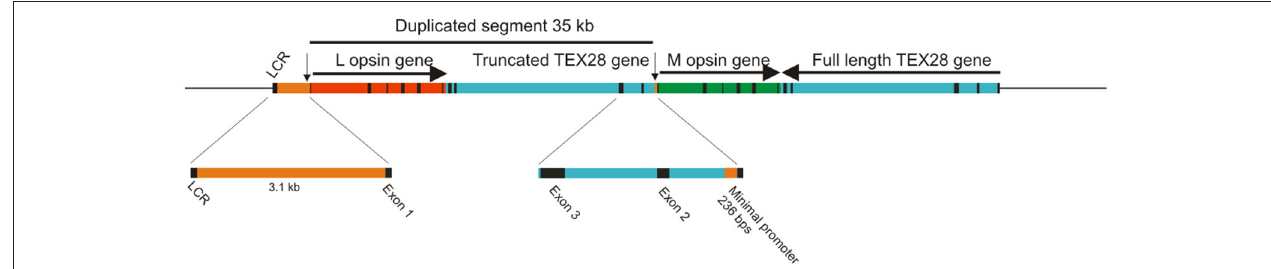
FIGURE 1 | Origin of opsin gene duplication on the X chromosome of Old World primates. The exons for the L and M opsin genes and for the TEX28 gene are shown as black bars. Arrows indicate the direction of transcription. The positions of the upstream LCR and the minimal promoters for the L and M opsin genes (vertical arrows) are shown.